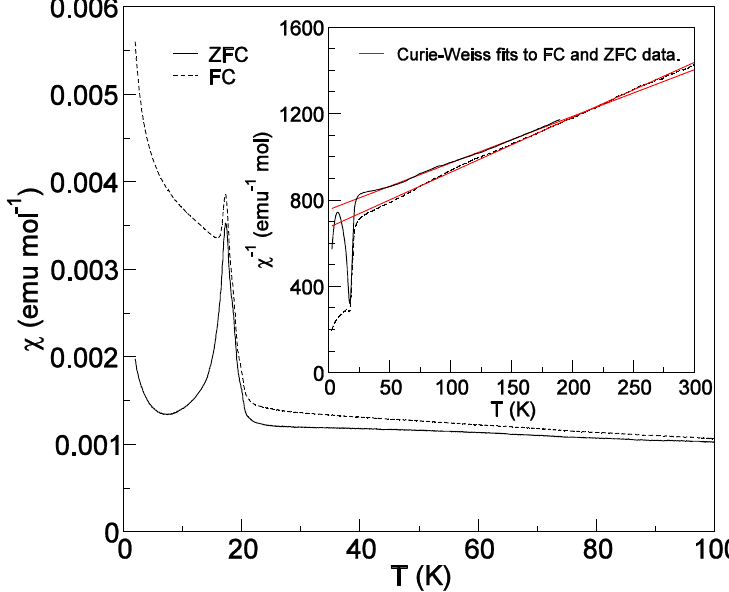
Figure 9. The zero-field cooled (ZFC) and field-cooled (FC) magnetic susceptibility data for a powder sample of Cs 2 TiCu 3 F 12 . The inset shows the inverse susceptibility with Curie-Weiss fits (red) to the linear sections of the